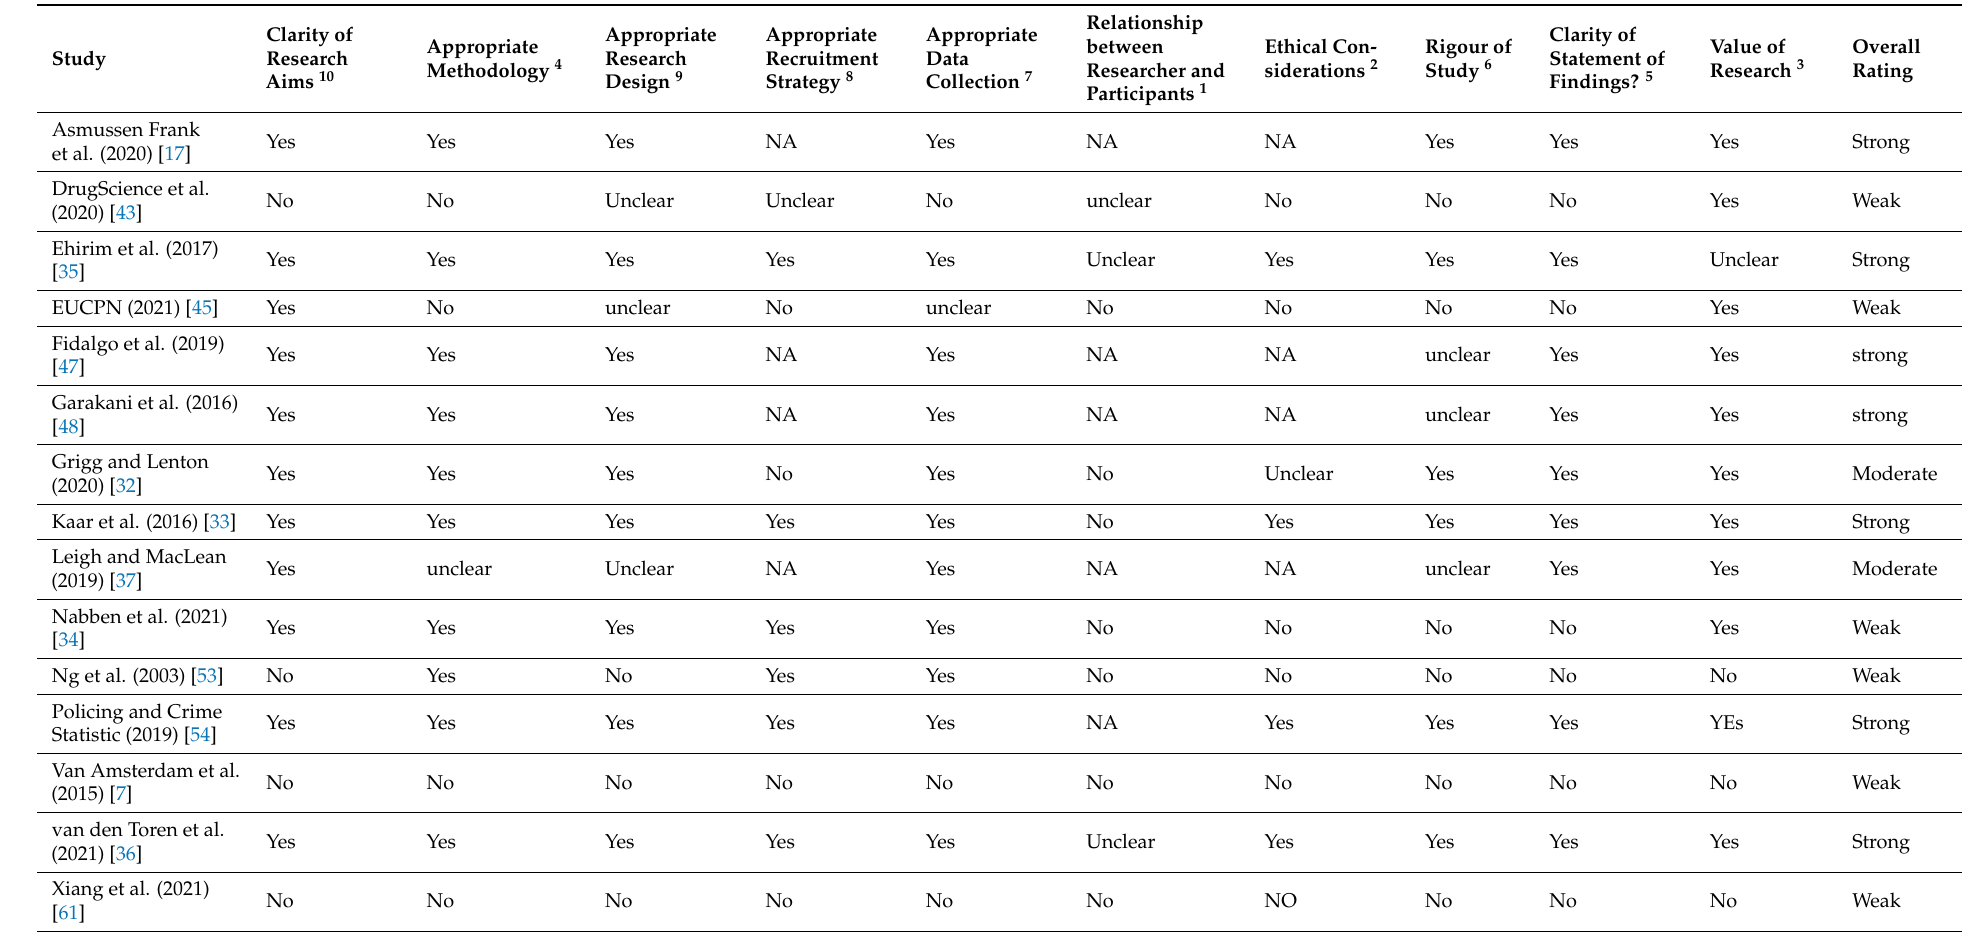
Table 2. Study ratings using the CASP